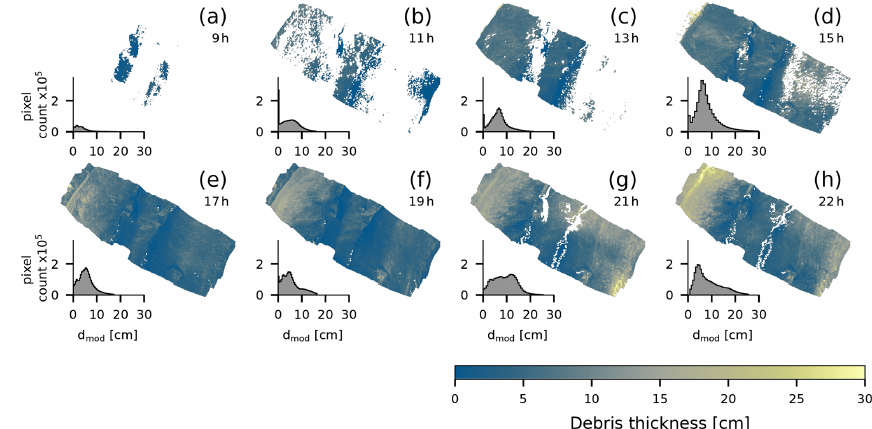
Figure 7. Estimated debris thicknesses for each flight time. White regions show regions where the surface energy balance model has no valid solution for debris thickness due to high uncertainties in the land surface temperature and reanalysis data. The histograms show the distribution of the predicted debris thicknesses displayed in the maps.